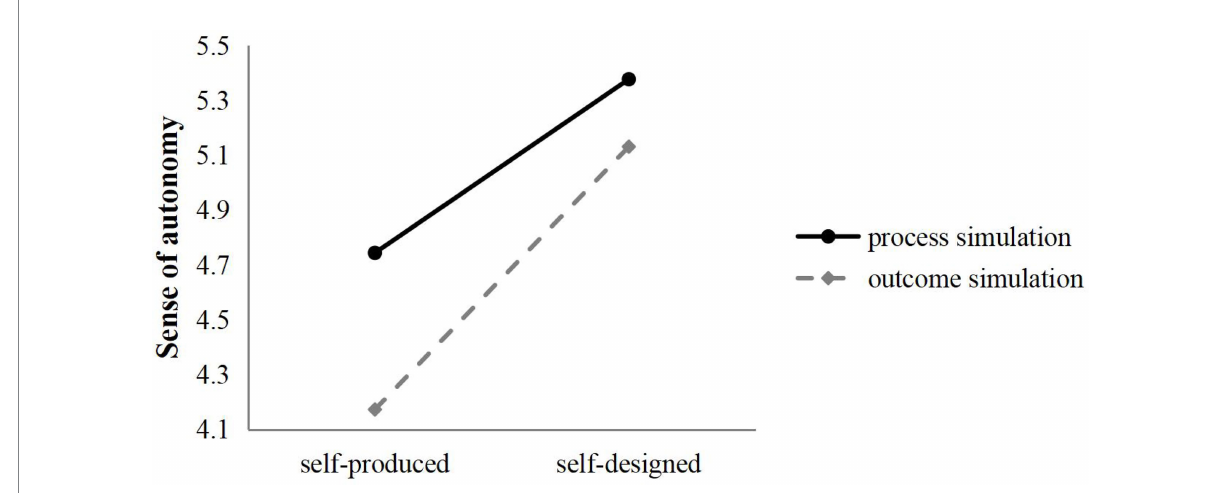
FIGURE 3 Moderating effect of mental simulation (sense of